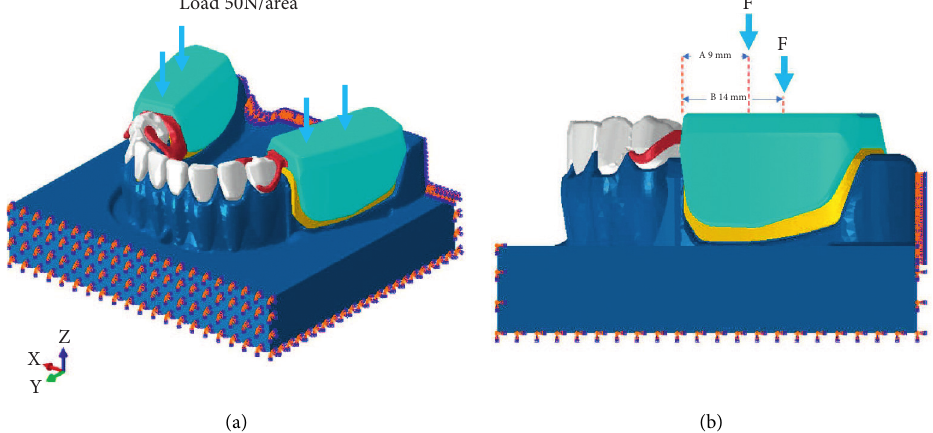
Figure 2: Full isotropic view of the FE model with loading and boundary condition (a) displays model capture at the front part (b) displays the loading location at the side view of the model with location of loading 9 and 14mm far from the